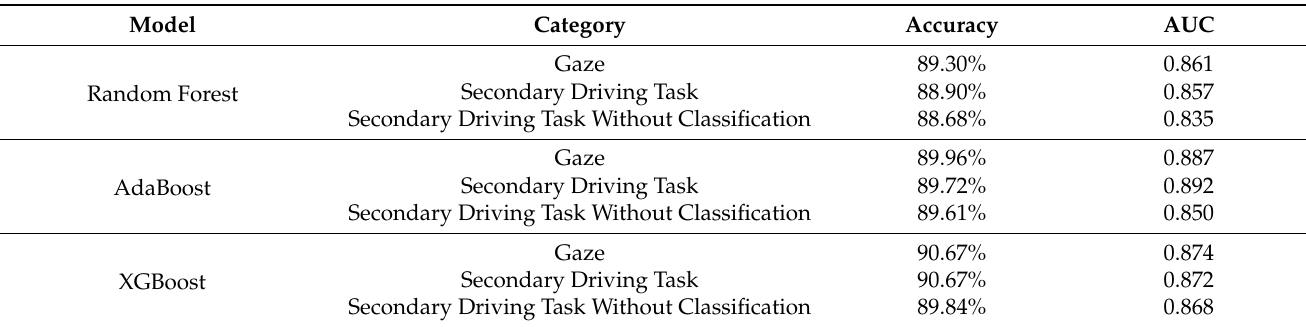
Table 11. Prediction accuracy.